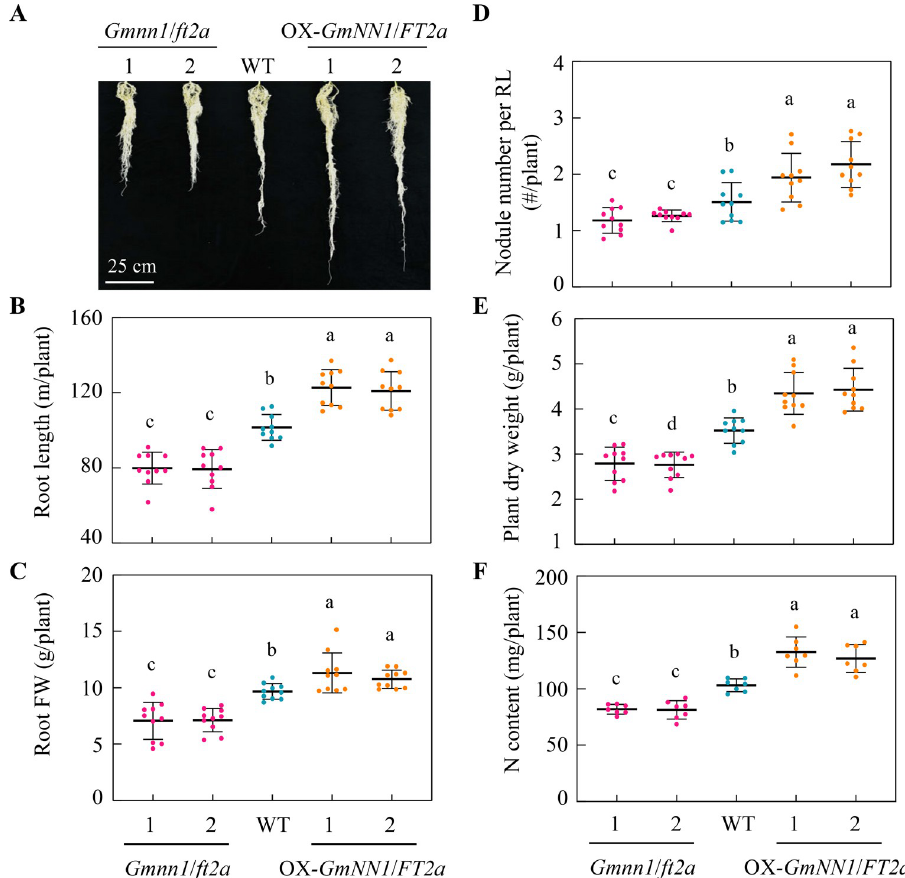
Fig 3. Plant growth, nodulation, and N content as affected by manipulating of GmNN1/FT2a. (A) Photographs showing soybean root growth performance. (B) Total root length ( n = 10). (C) Root FW ( n = 10). (D) Nodule number per RL ( n = 10). (E) Plant dry weight ( n = 10). (F) N content ( n = 7). WT and transgenic soybean lines with knockout or overexpression of GmNN1/FT2a inoculated with rhizobia were grown in hydroponic for 21dai. All data are given as mean ± SD. Different letters denote significant differences ( P < 0.05) according to Duncan’s multiple range comparison tests. Data underlying the graphs in the figure can be found in S1 Data. dai, day after inoculation; FW, fresh weight; N, nitrogen; RL, root length; WT, wild